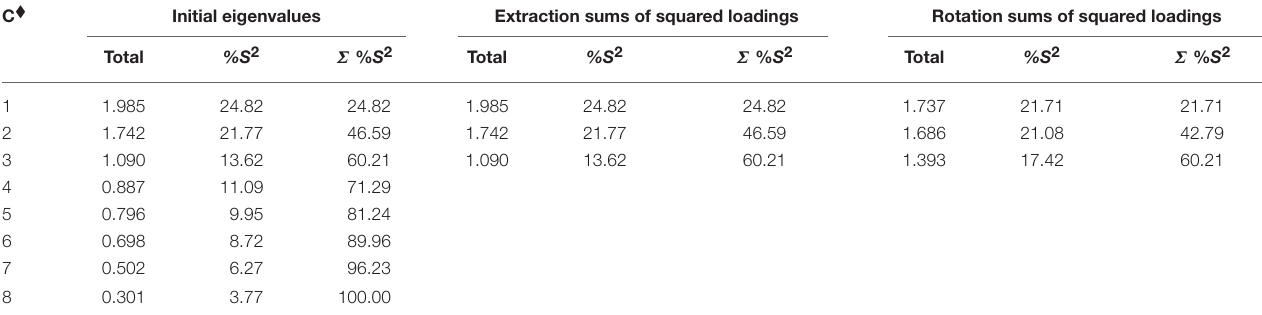
TABLE 9 | Total variance explained, extraction method: principal component